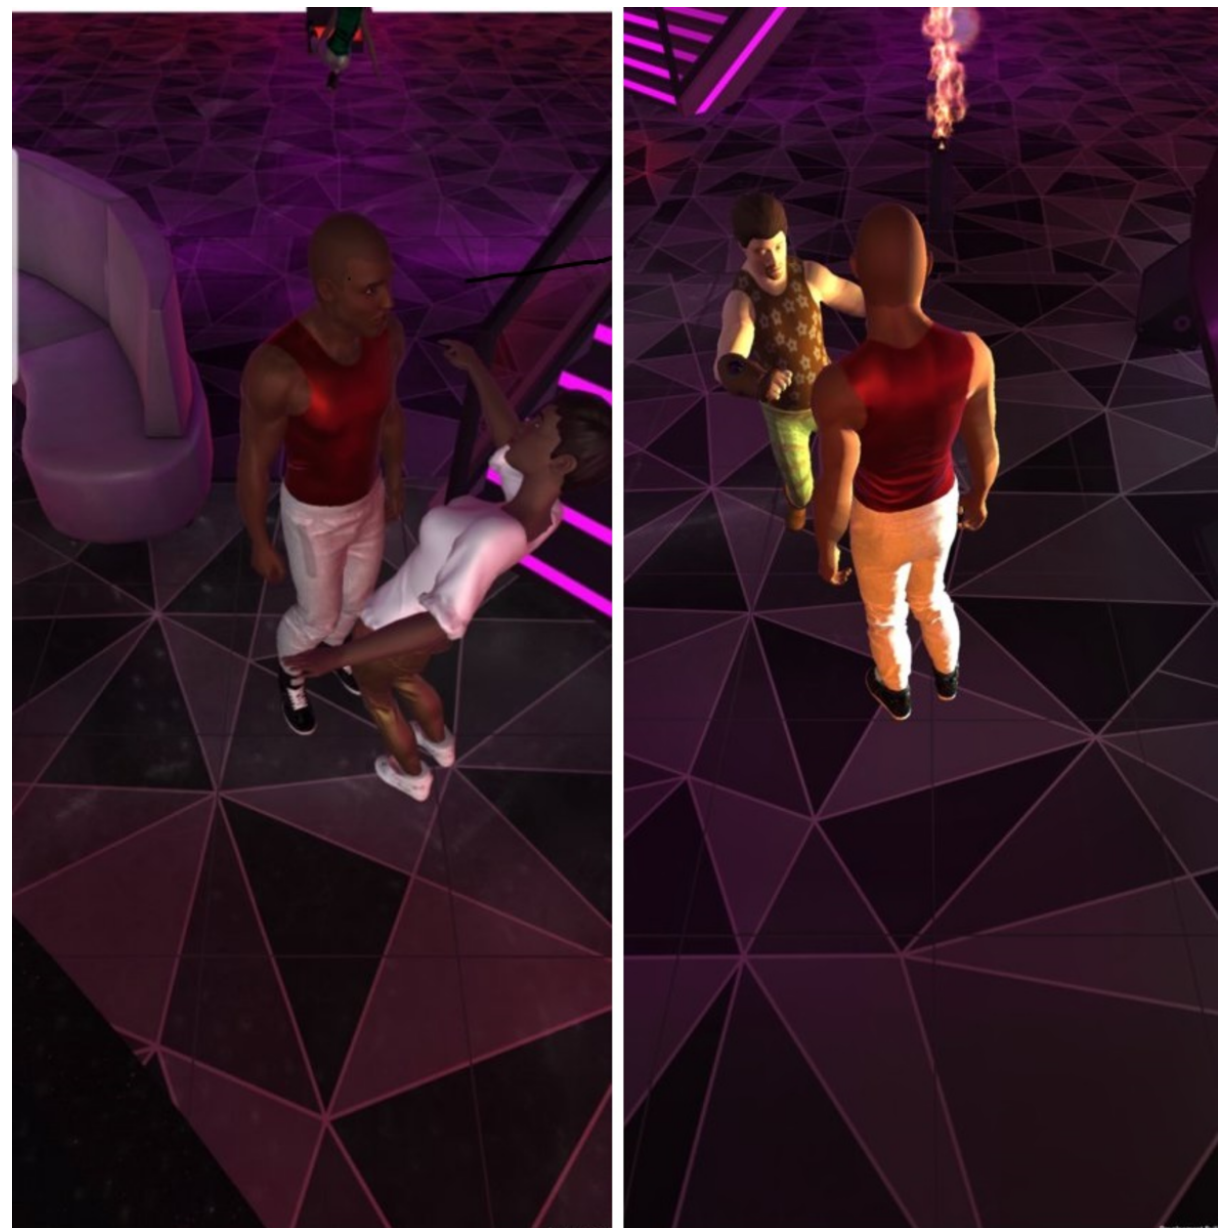
Figure 2. Draft scene of opposite sex and same sex